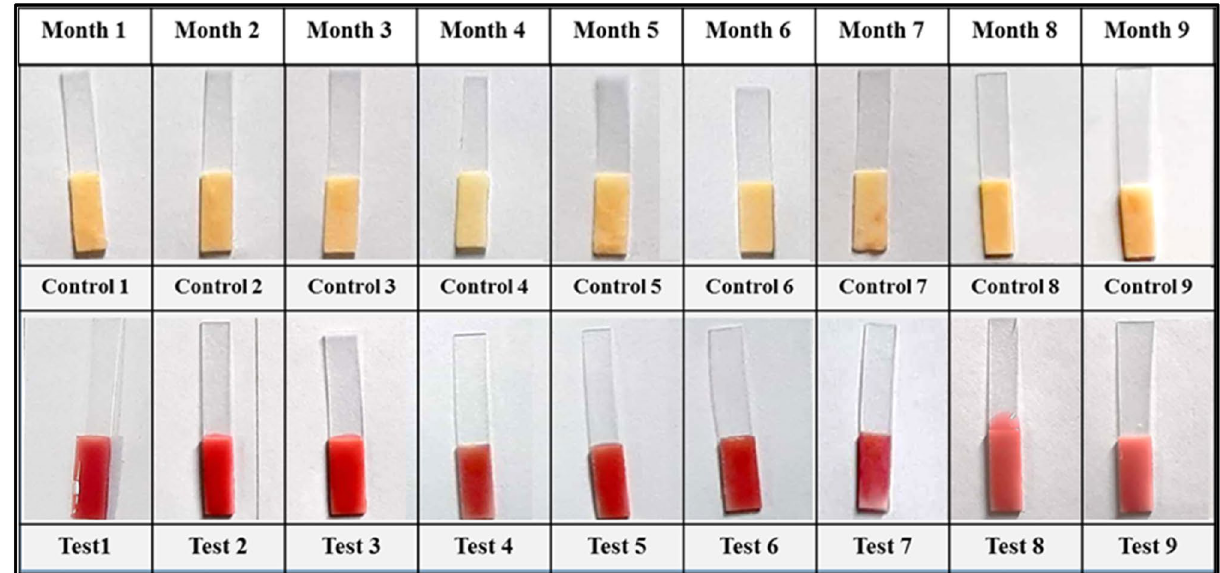
Figure 10. Shelf life stability of vacuum packed, substrate functionalized paper strip stored at − 20 °C, shows the best colour intensity up to 9 months of storage.